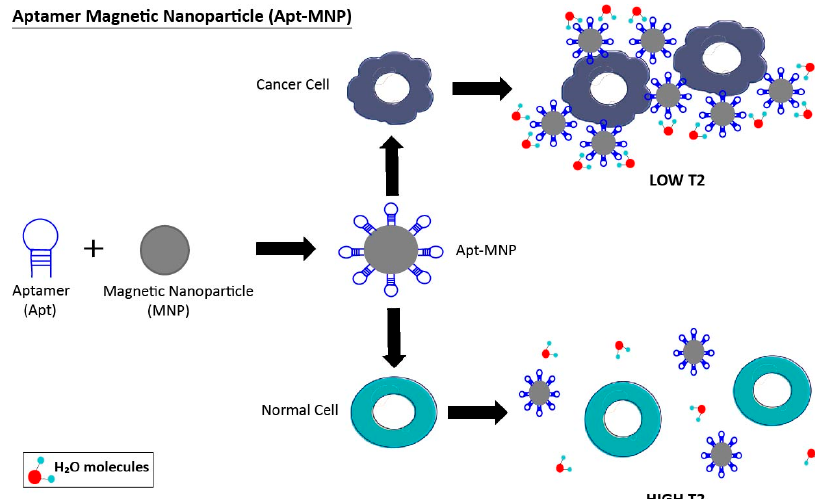
Figure 3. Aptamer-magnetic nanoparticle (Apt-MNP) clusters bind to cancer cells and lead to the aggregation of these magnetic molecules. The accumulation of Apt-MNPs around tumor cells cause a decrease in the T2 of adjacent water protons. Whereas, in the presence of normal cells, Apt-MNPs are well dispersed, resulting in a high T2 of surrounding water protons. T2 = spin-spin relaxation time or transverse relaxation time is a measure of the rate of decay of transverse magnetization within the x-y plane, and is reported in milliseconds.